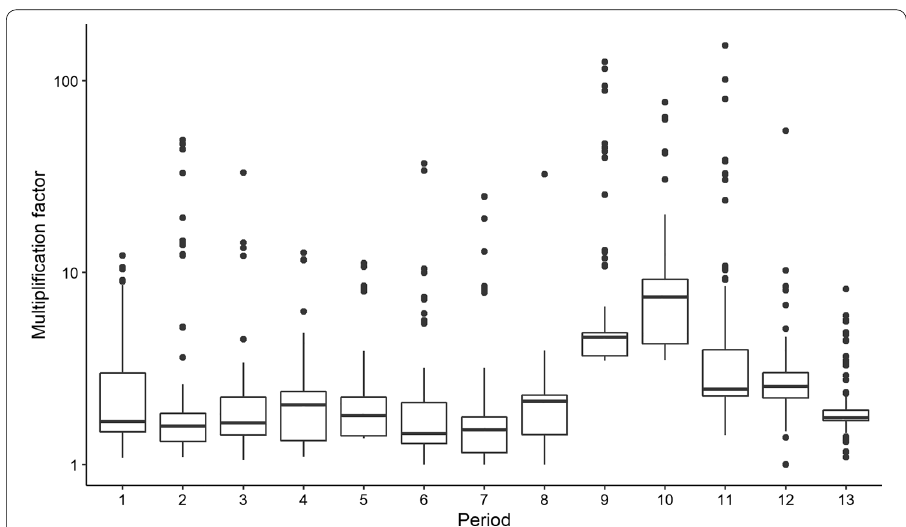
Fig. 8 Multiplication factor distribution considering only cattle premises having an OCC of more than 10 premises